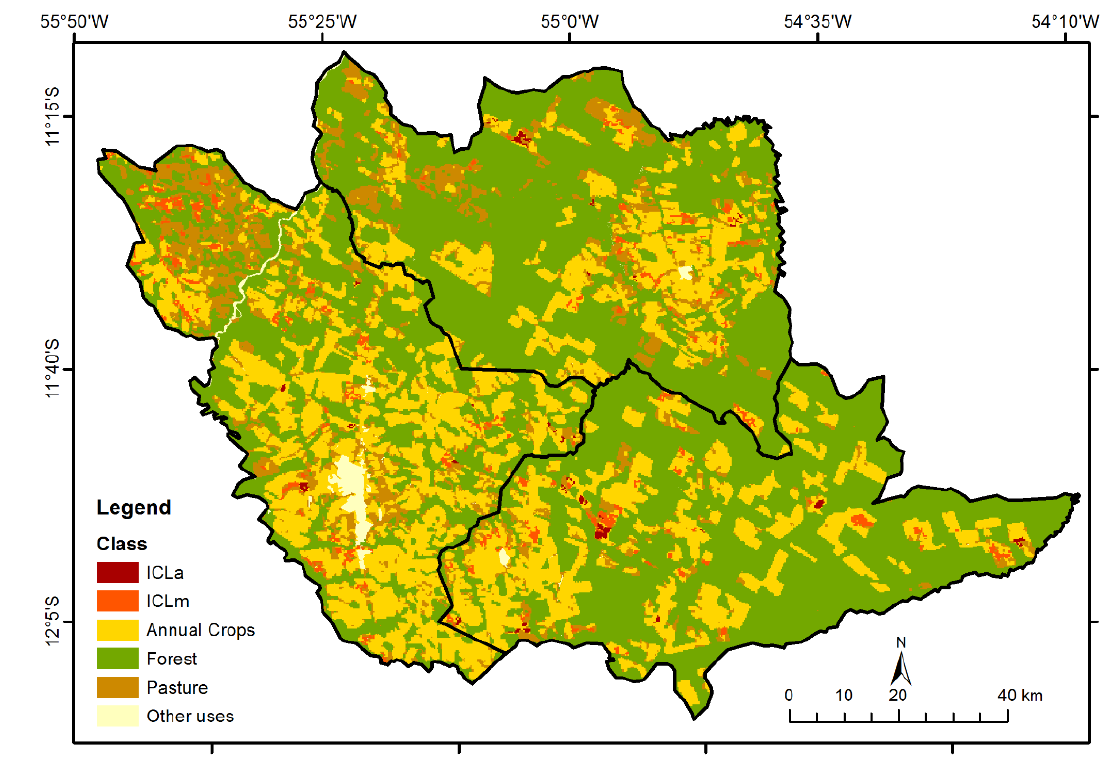
Figure 8. Integrated crop-livestock classification for 2016.